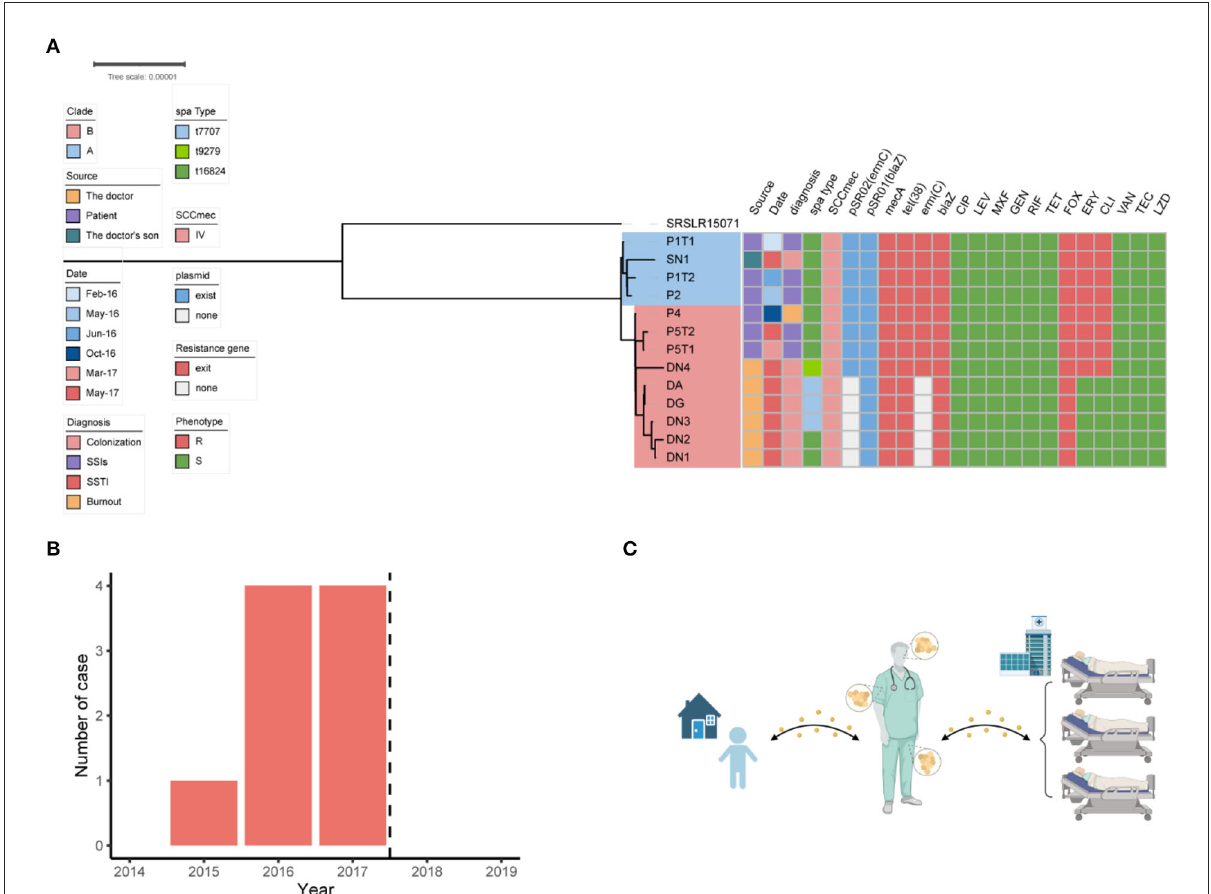
FIGURE2 Dissemination analysis of the ST88 strain in this disease area. (A) Phylogenetic tree of the ST88-methicillin-resistant Staphylococcus aureus (MRSA) isolates disseminated in this ward. (B) Annual number of MRSA-infected patients in the ward. Dotted lines represent the dates when surgeons colonized with MRSA ceased their medical activity. (C) Transmission pattern of ST88-MRSA strains in this